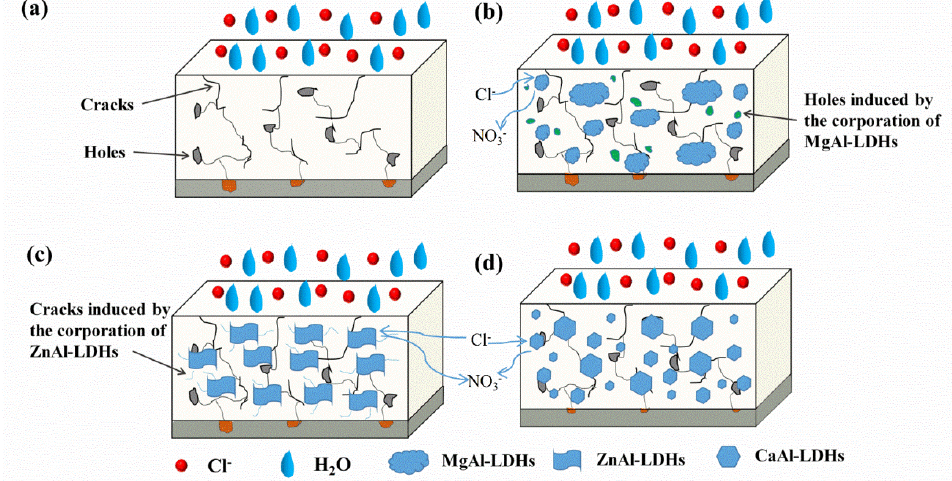
Figure 20. The schematic illustration of the corrosion protection mechanism ( a ) blank epoxy coating; ( b ) epoxy coating with 2% MgAl-LDH; ( c ) epoxy coating with 2% ZnAl-LDH; ( d ) epoxy coating with 2% CaAl-LDH.